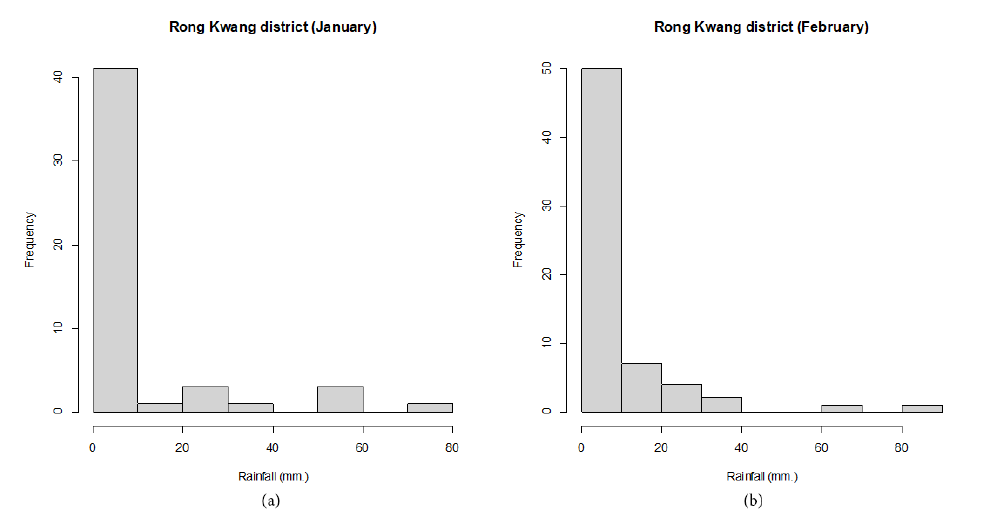
Figure 7. The densities of the rainfall data from Rong Kwang district station, Phrae province, Thailand, for ( a ) January from 1969–2021 and ( b ) February from 1953–2021.